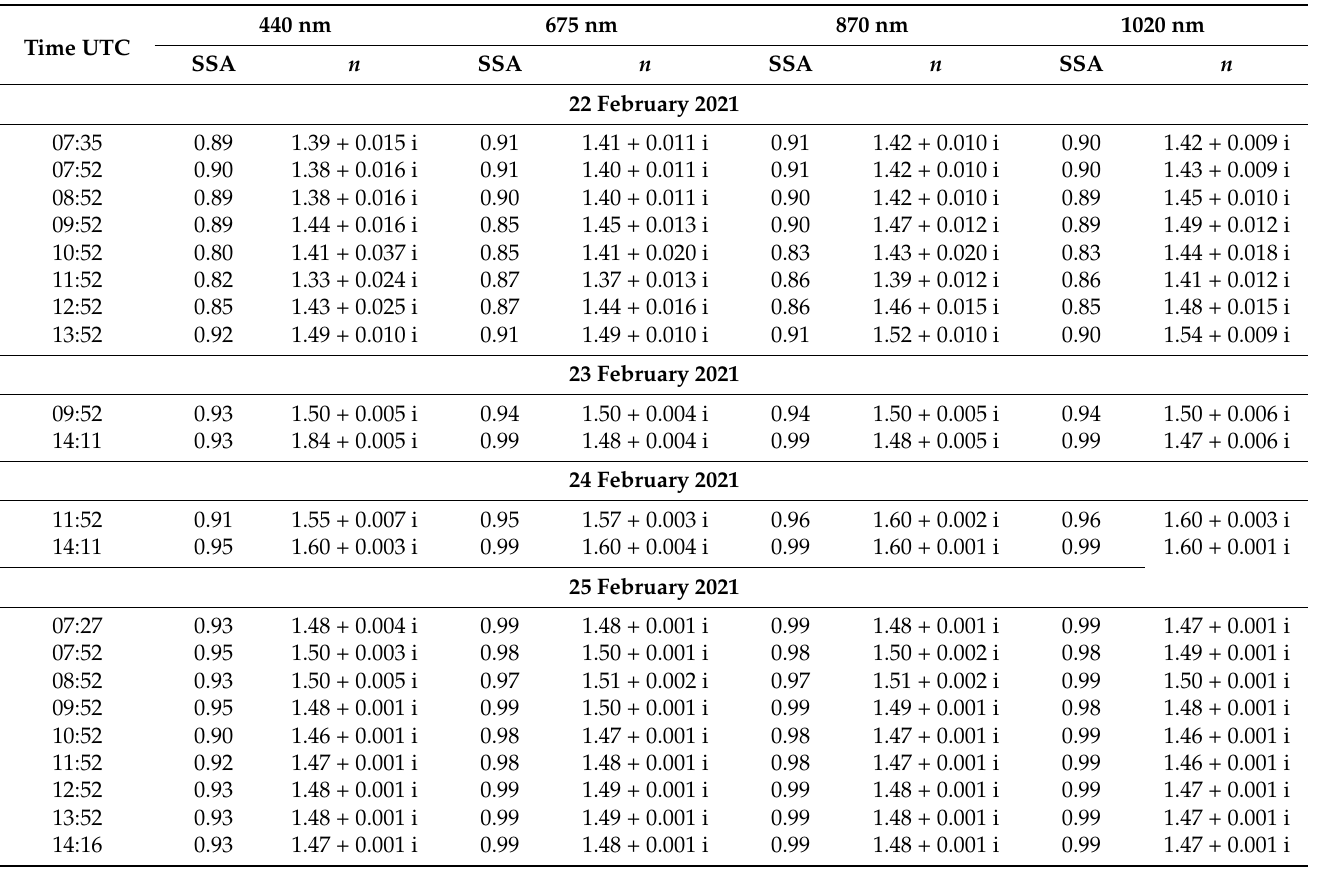
Table 3. Single Scattering Albedo (SSA) and Radiative Index ( n ) obtained for 440, 675, 870 and 1020 nm from the almucantar scans via Version 3 Inversion algorithm on 22–25 February 2021 calculated by AERONET-NASA with level 1.5 data. Analysis shows significant changes in the imaginary part of n between 22 February 2021 and 23–25 February